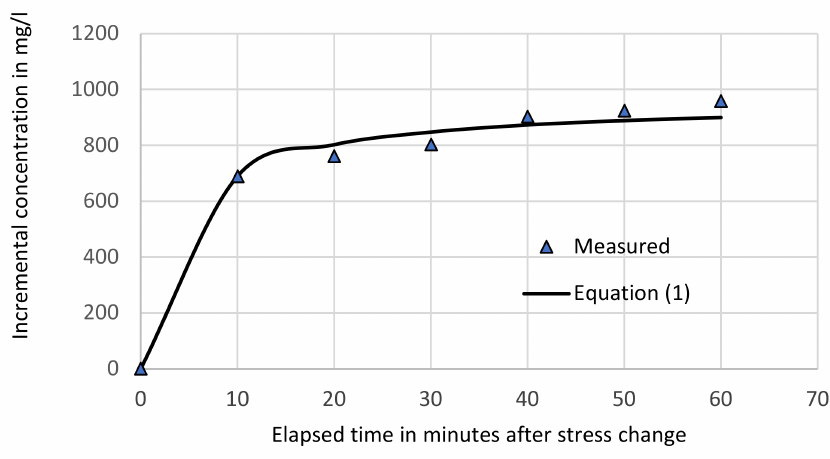
Figure 5. Comparison between measured and fitted sediment concentrations using Equation (1) for shear stress step: 0.17 Pa; Age of deposit: 38 h (r 2 =